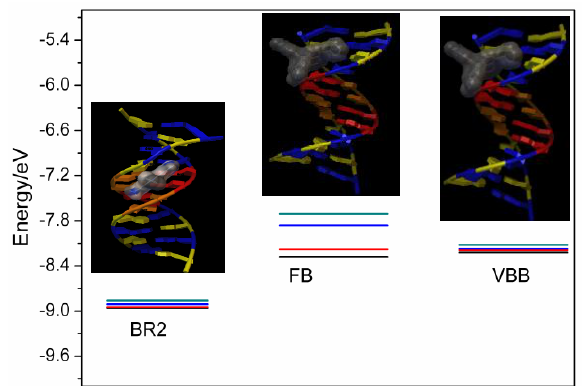
Figure 10. The lowest binding energies and the most stable conformations between FB, BR2 and VBB based on the lowest free binding energy.